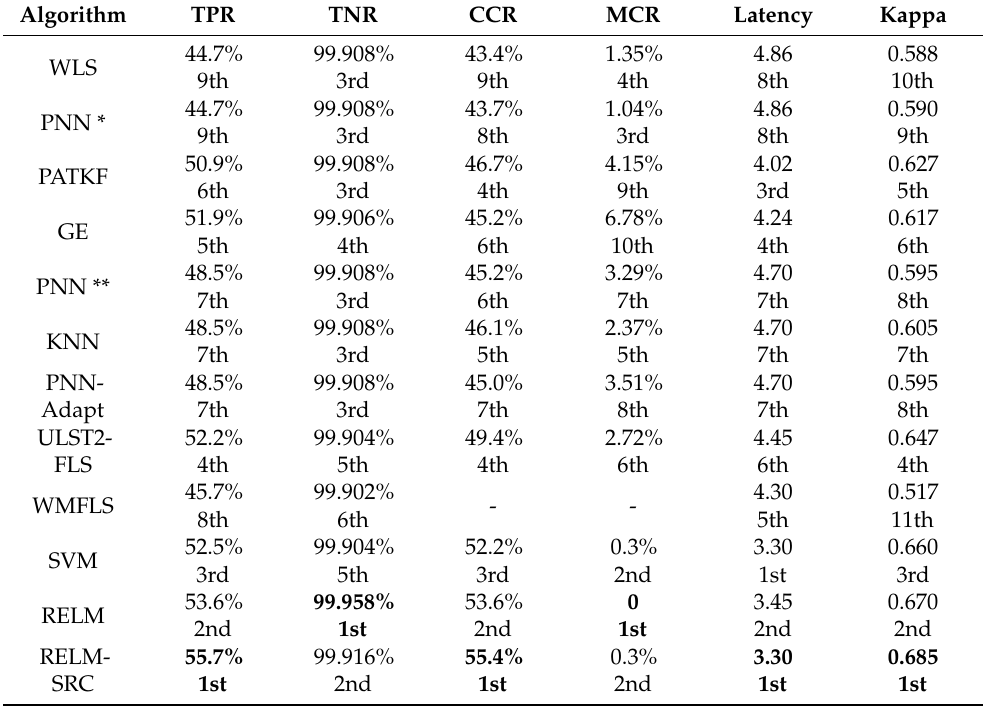
Table 11. Metrics for ProDiMES blind test dataset and multi-point analysis, averaged for abrupt and rapid faults (Stage